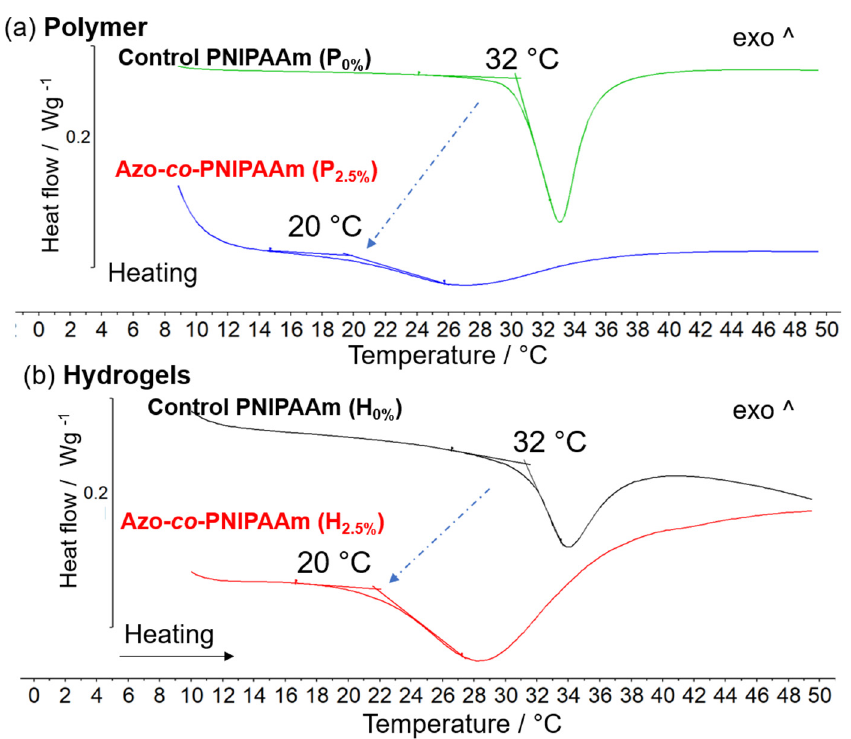
Figure 4. DSC scans (10 K/min) comparing the effect of incorporating 2.5 mol% of Azo(1) on the lower critical solution temperature (LCST) of the control PNIPAAm in ( a ) polymers P 0% and P 2.5% and ( b ) hydrogels H 0% and H 2.5% .